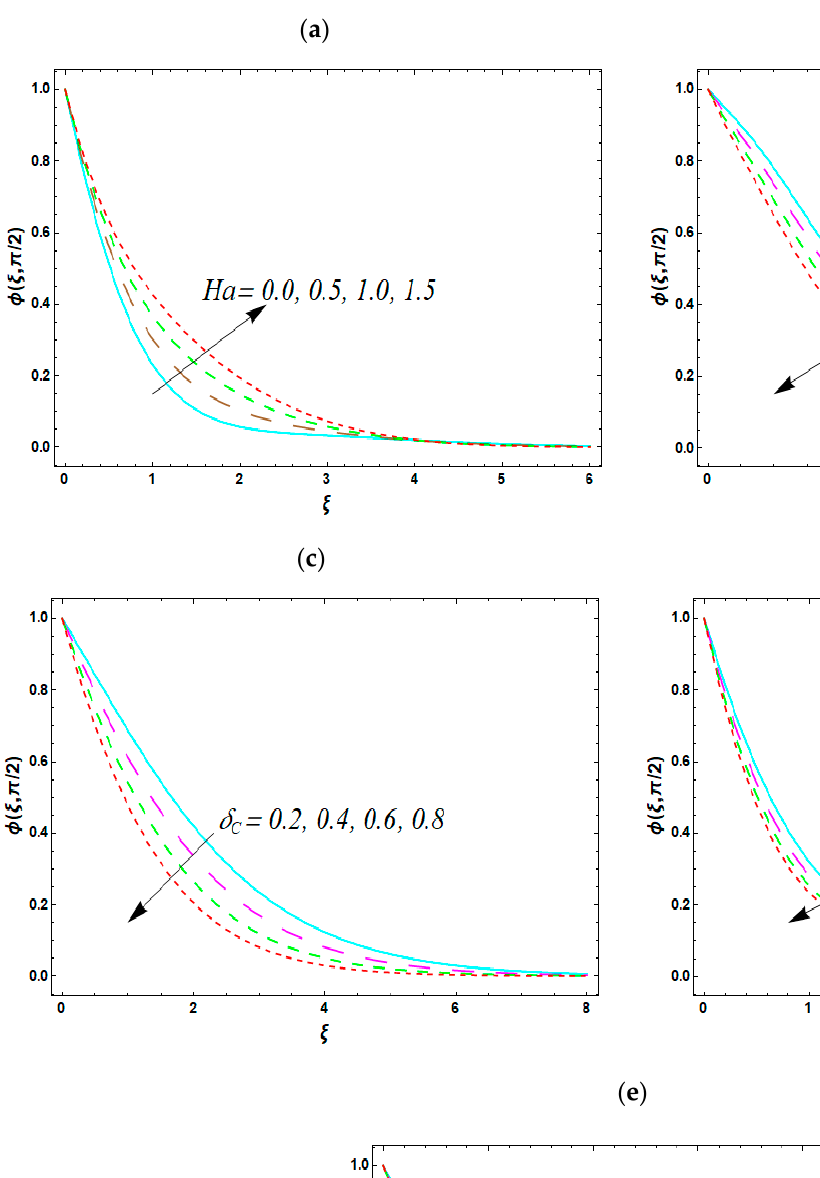
Figure 5. Temperature pro fi les for various values of ( a )